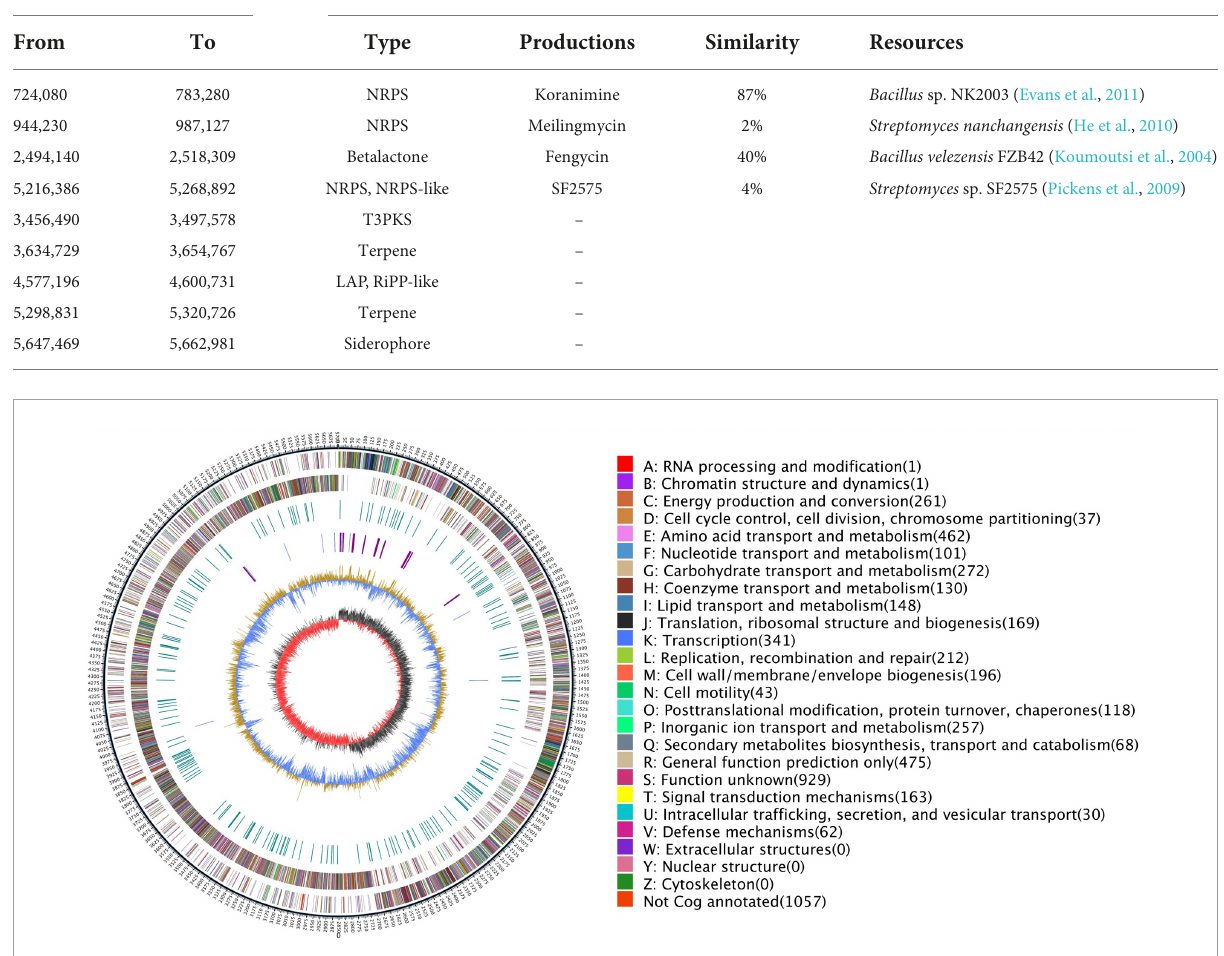
FIGURE2 Genome map of Q2H1: The outermost circle is the indication of the genome size; the second and third circles are genes on the positive and negative strands of the genome, respectively; and different colors represent different COG functional classifications; the fourth circle is the repeat sequence; the fifth circle is tRNA and rRNA, blue is tRNA, and purple is rRNA; the sixth circle is the GC content; and the innermost circle is GC skew. A–Z, respectively, show the functional classification of the CDS genes in the